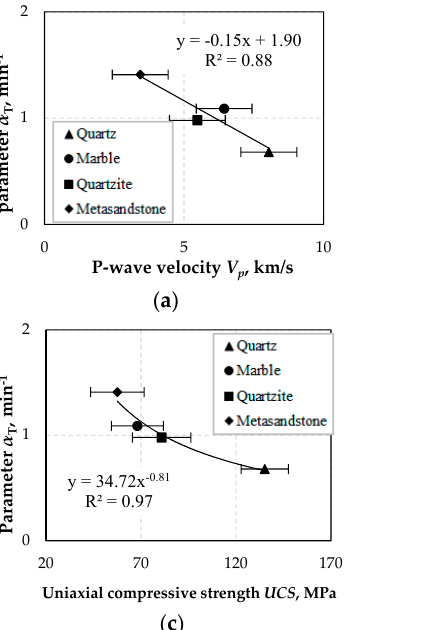
( d ) Figure 12. Correlations between parameter α and ( a ) P-wave velocity V p , ( b ) Schmidt rebound values R L , ( c ) uniaxial compressive strength UCS and ( d ) tangent modulus of elasticity E t ; horizontal error bars show standard deviation of the measurements. The correlations between maximum breakage rate S m and V p , R L , UCS and E t are presented in Figure 13. Very strong correlation (R 2 = 0.96) is shown between S m and R L with the use of an inverse linear function. Furthermore, S m seems to follow an inverse exponential relationship with UCS , with correlation coefficient R 2 = 0.95. However, the prediction of S m from V p and E t values is somehow risky due to the moderate correlation between these variables.